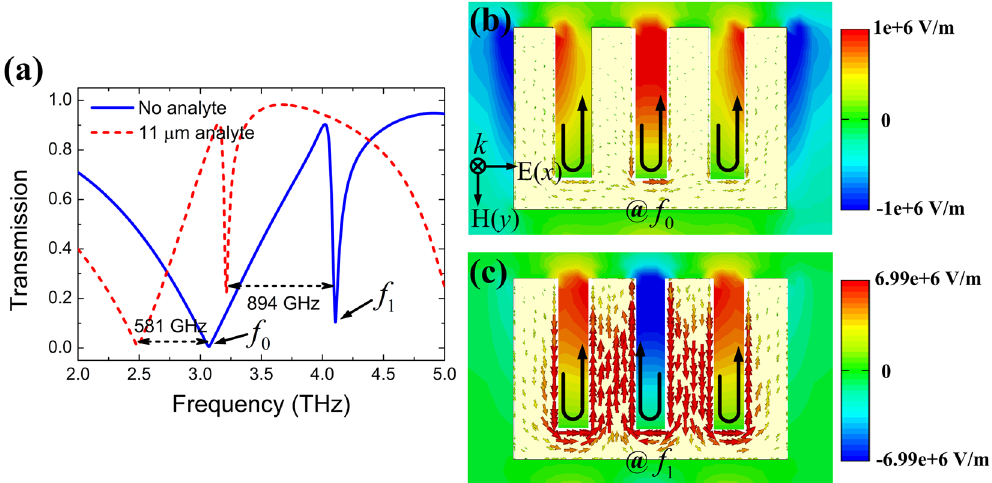
Figure 2. ( a ) Transmission spectra of the MMs structure without analyte (blue solid line) and with 11 μ m thick analyte layer (red dotted line), the refractive index of analyte is n = 1.6. ( b , c ) Electric field and surface current distributions of the MMs structure at frequencies f 0 and f 1 without analyte layer. The black arrows indicate the surface current